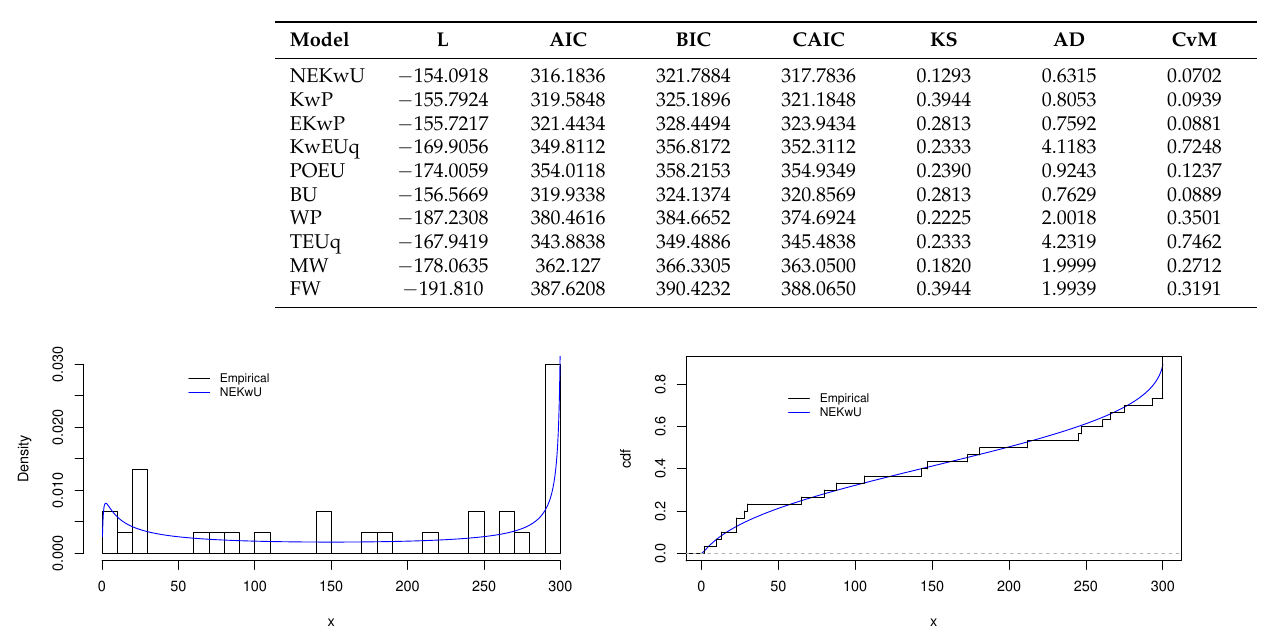
Table 7. Estimated log-likelihood value, model selection criteria, and goodness-of-fit measures of the considered models for the first data set.